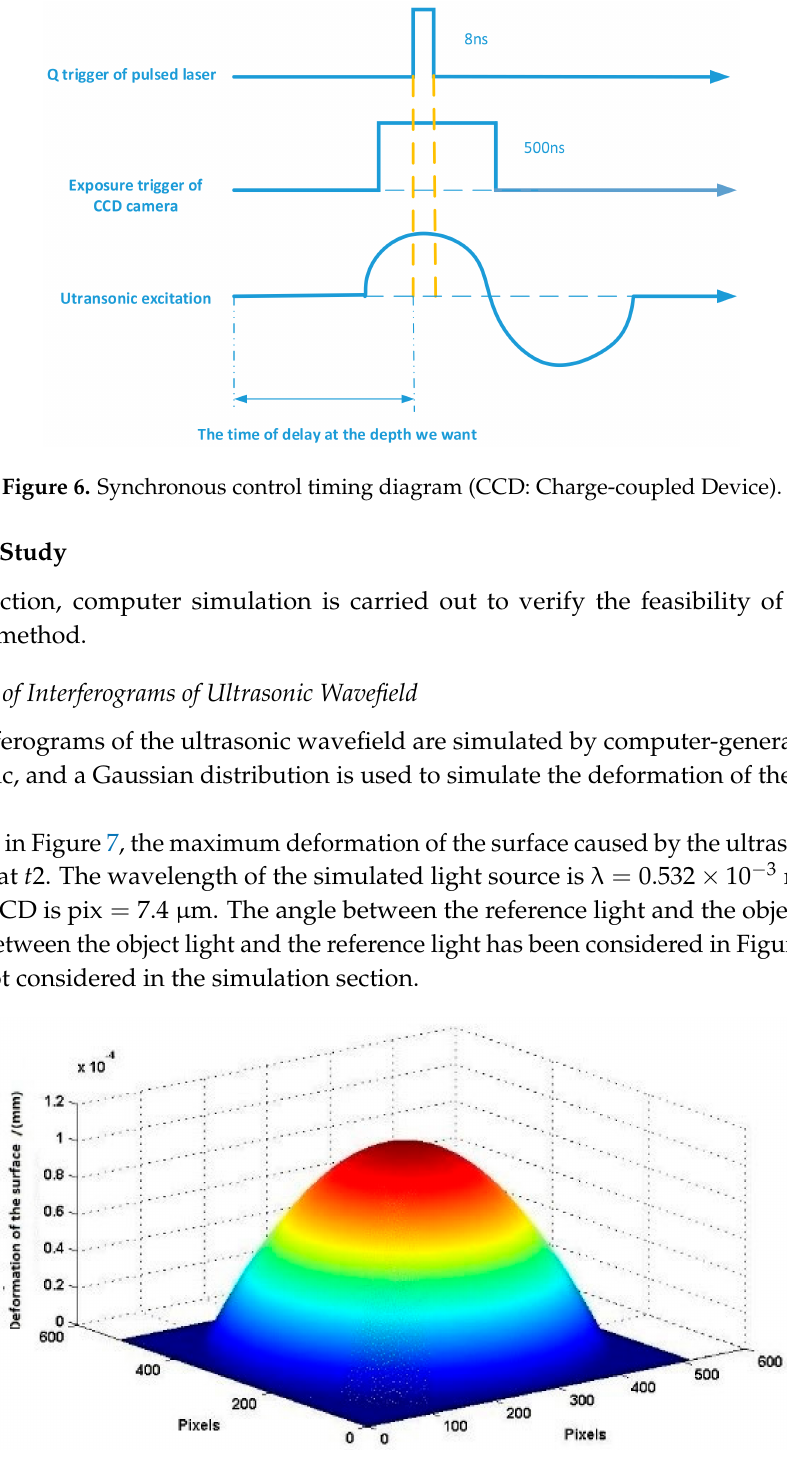
Figure 7. Surface of a longitudinal ultrasonic